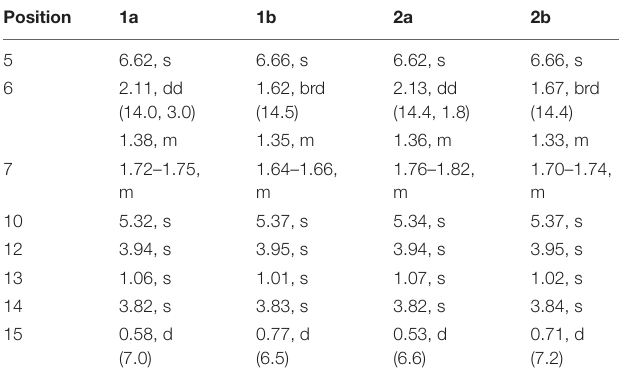
TABLE 1 | 1 H NMR Data (500 MHz, DMSO- d 6 , δ in ppm, J in Hz) for 1 and 2.